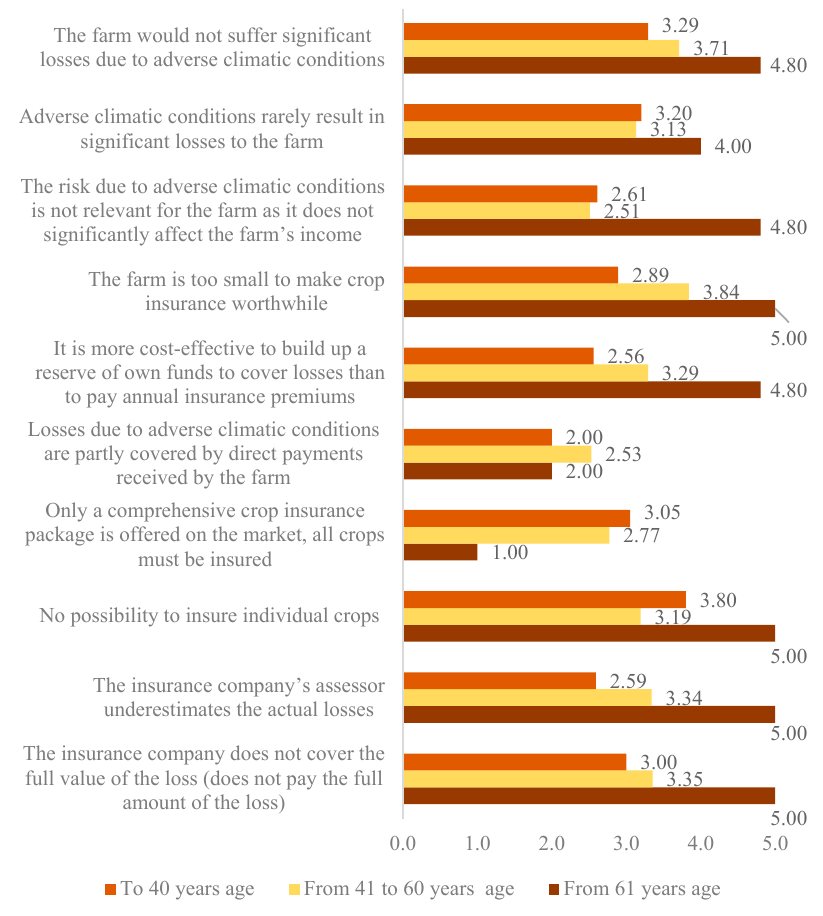
Figure 6. Reasons why farmers of different ages are hesitant about crop insurance.